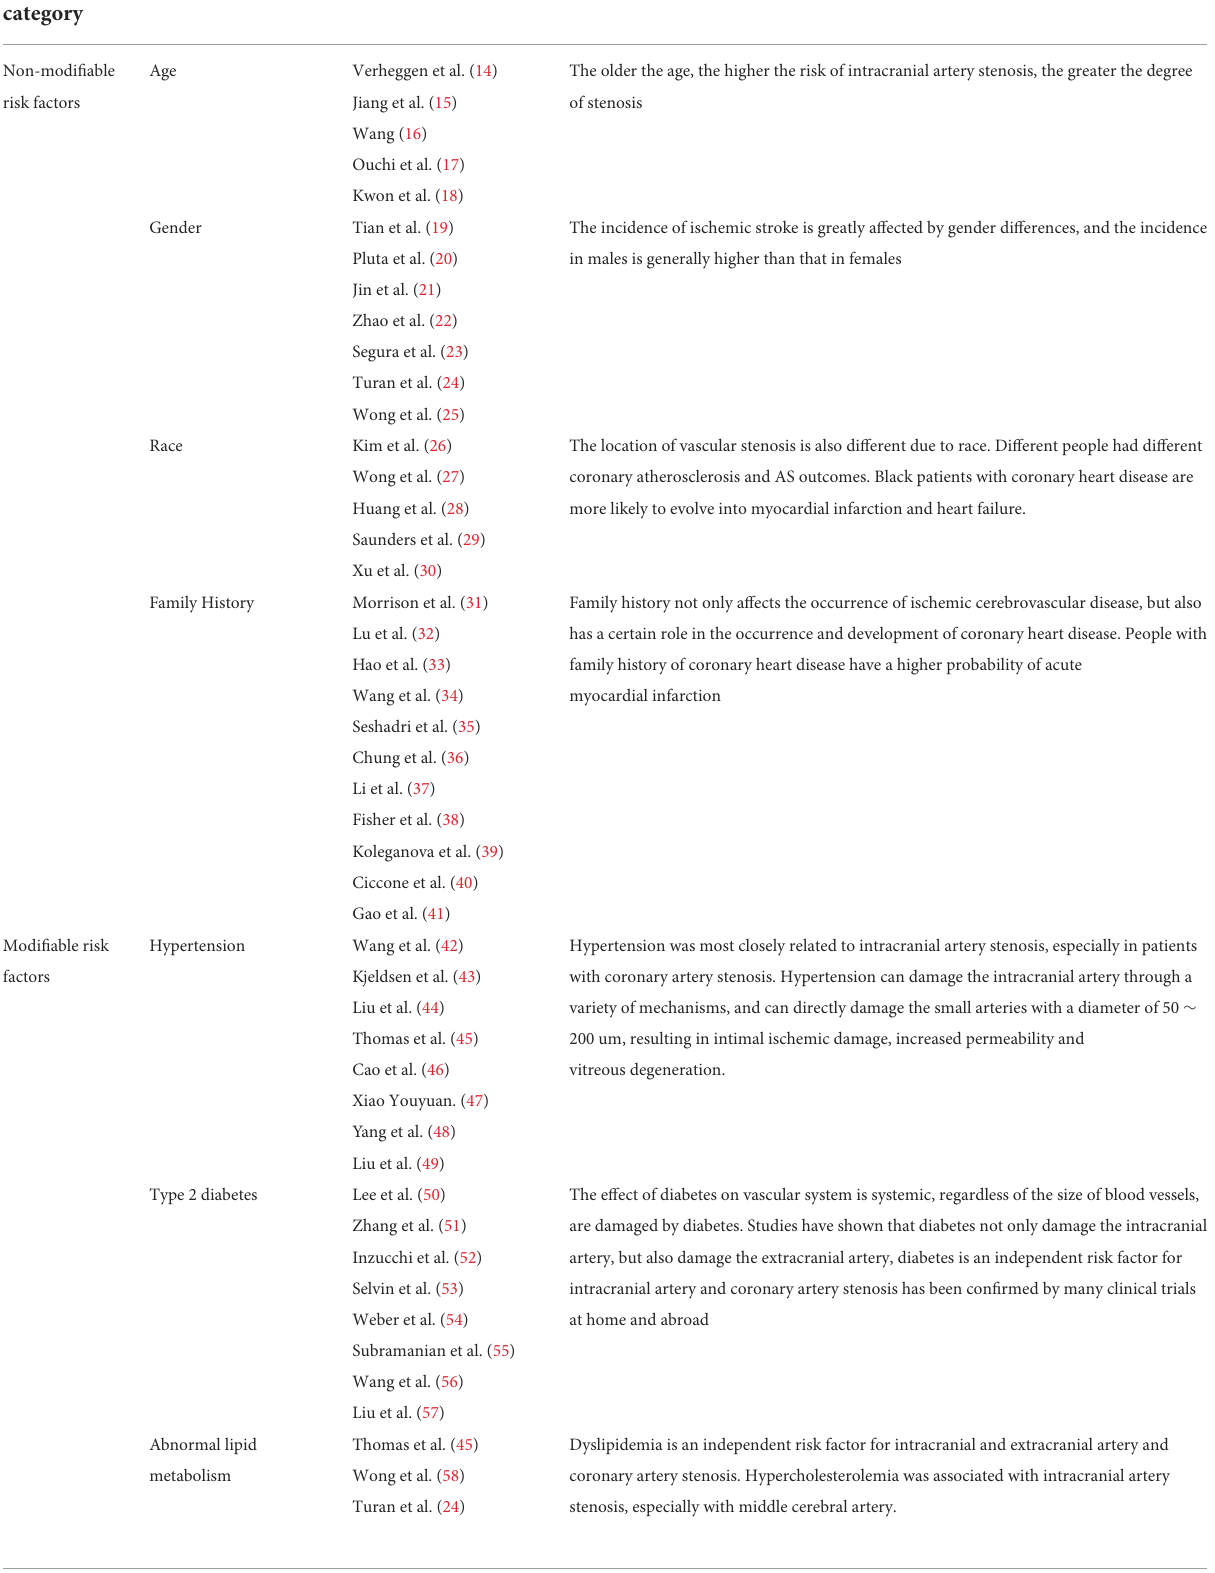
TABLE 1 Correlative risk factors of intracranial artery, carotid artery, and coronary artery